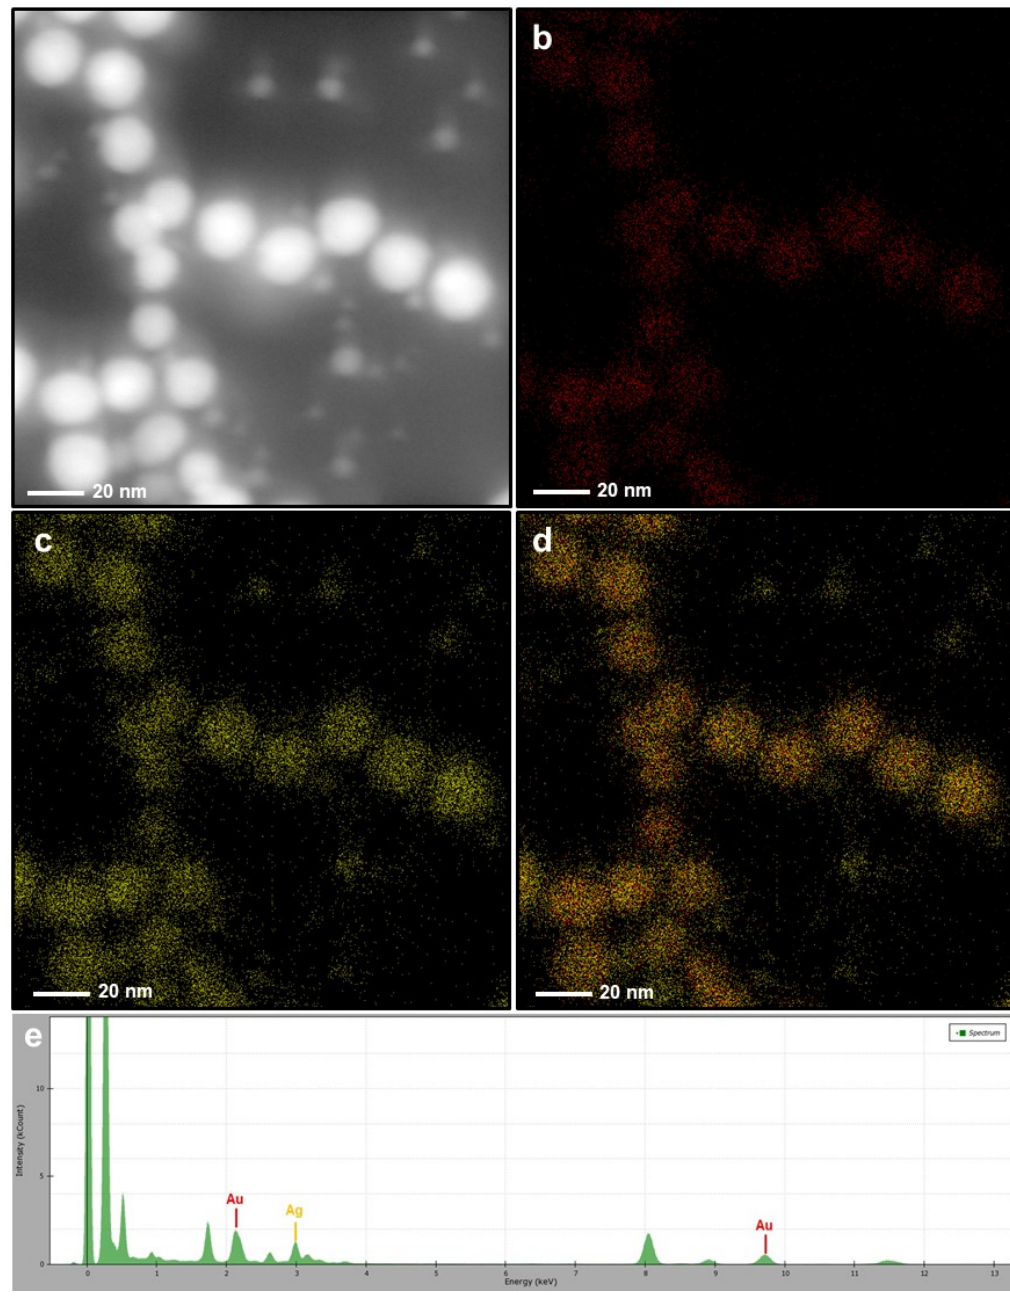
Figure 4. Elemental mapping and EDAX spectrum of the AuNP@30PDOP@30AgNP system. Electron micrograph region ( a ), distribution of gold elemental mapping ( b ), distribution of silver elemental mapping ( c ), overlay of gold and silver ( d ), and relevant EDX spectrum ( e ).